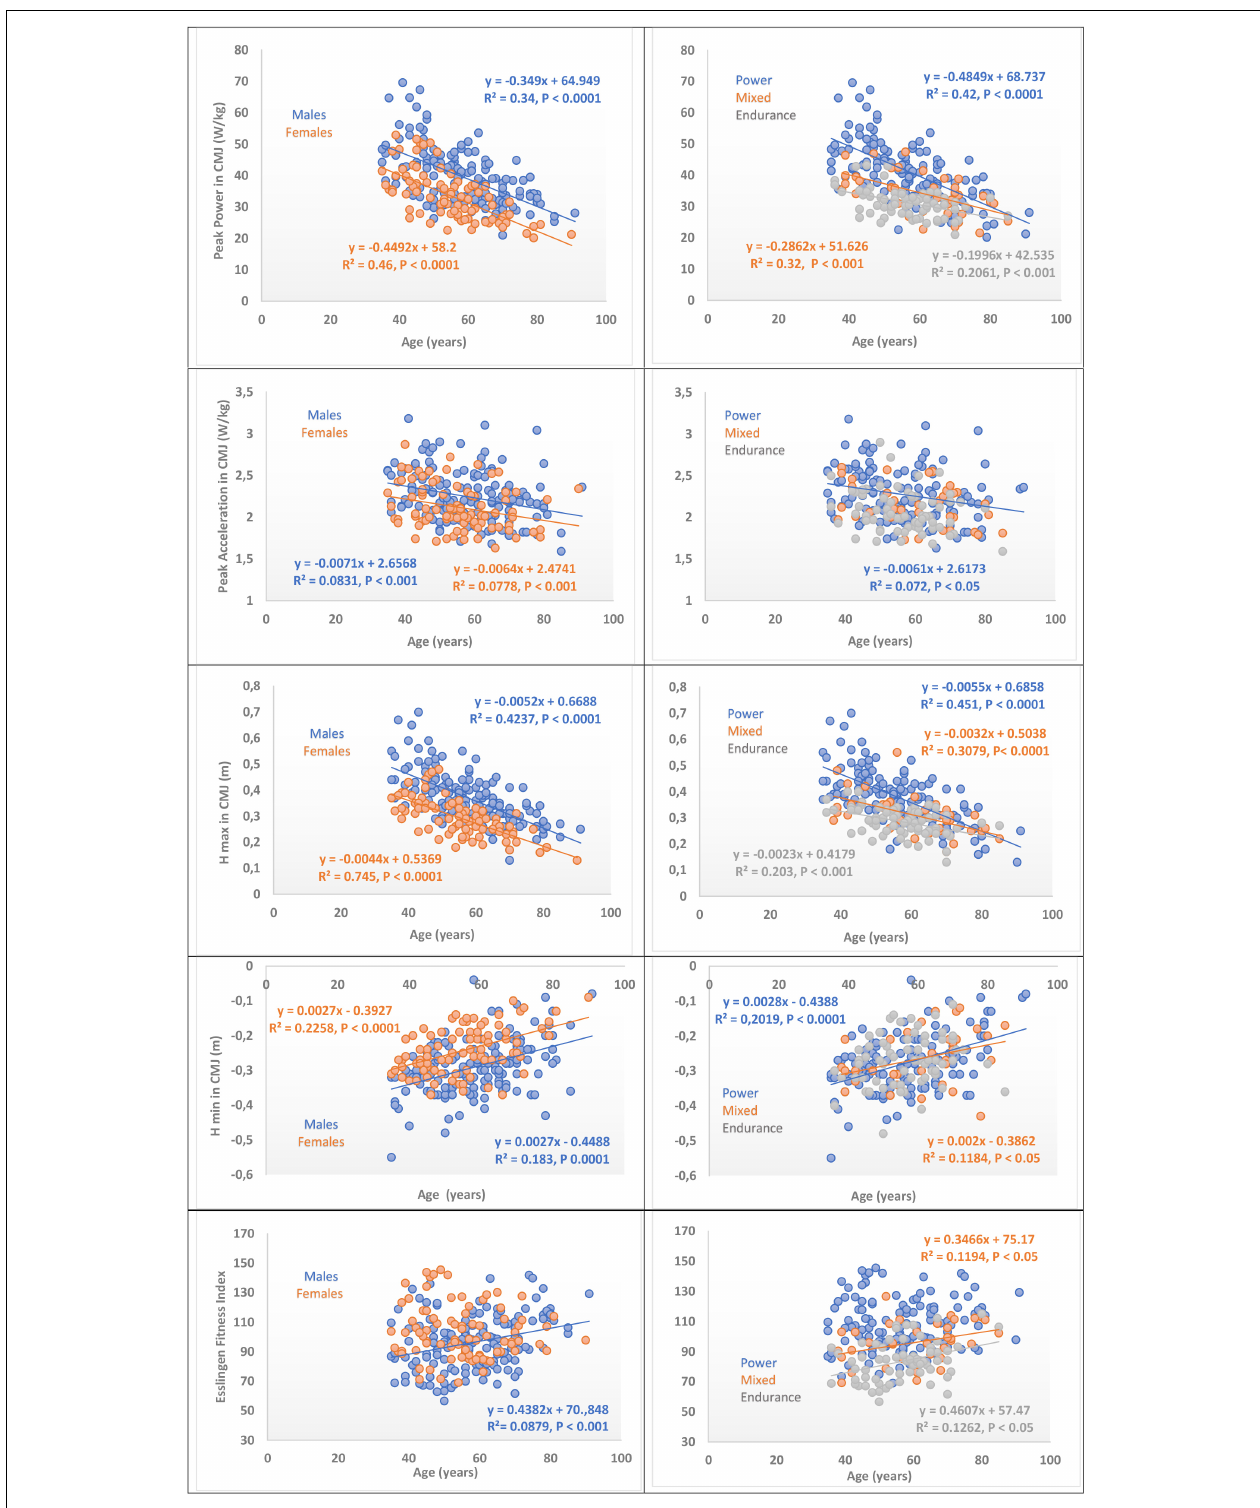
FIGURE 1 | Age dependency of vertical jump test performance of Master Athletes. At left: Comparison of variables by gender. At right: Comparisons of variables by sport specialty. Regression lines and equations are represented and consigned when they are significant (see correlation coefficients between variables in Tables 3A,B